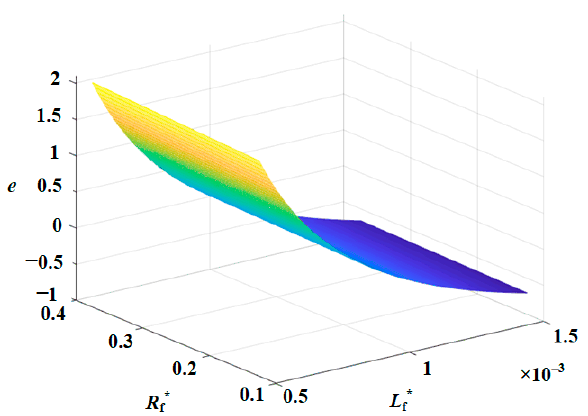
Figure 3. The influence of resistance parameter changes on the model.